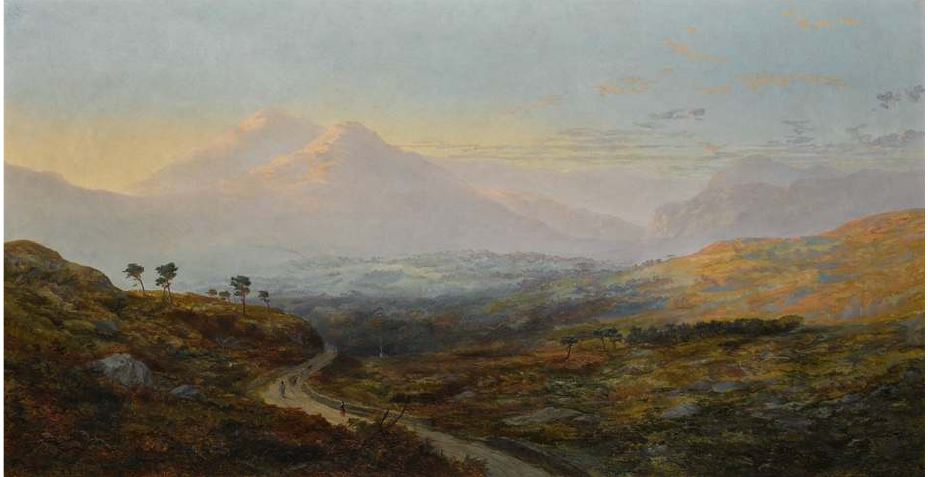
Figure 5: William McEvoy, Glengariff from the Kenmare Road, Evening (1862), 71 x 132